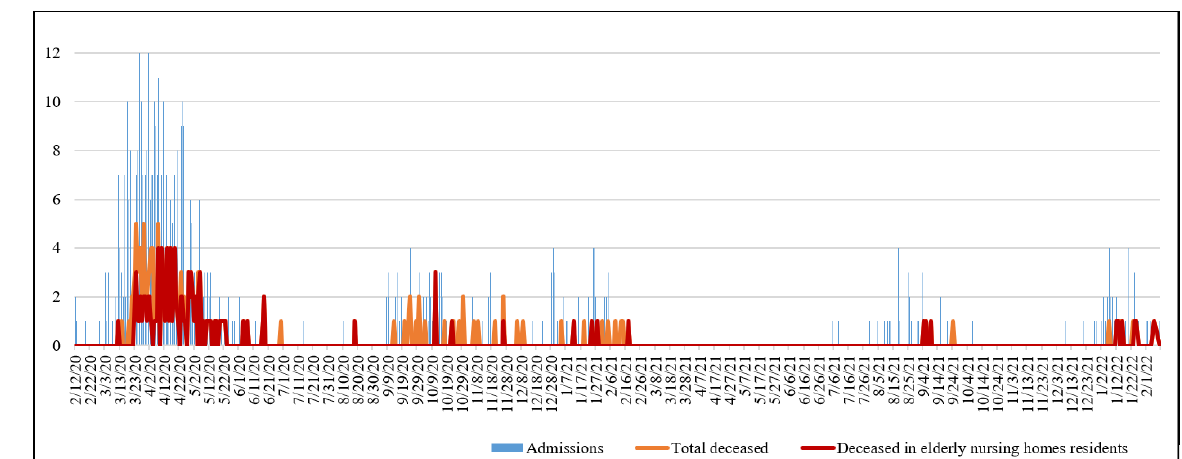
Figure 1. Evolution of hospital admissions and deceased patients because of COVID-19 during six pandemic waves. HCCR. Table 3. Clinical and sociodemographic factors among patients who survived and died, infected by SARS-CoV-2 in